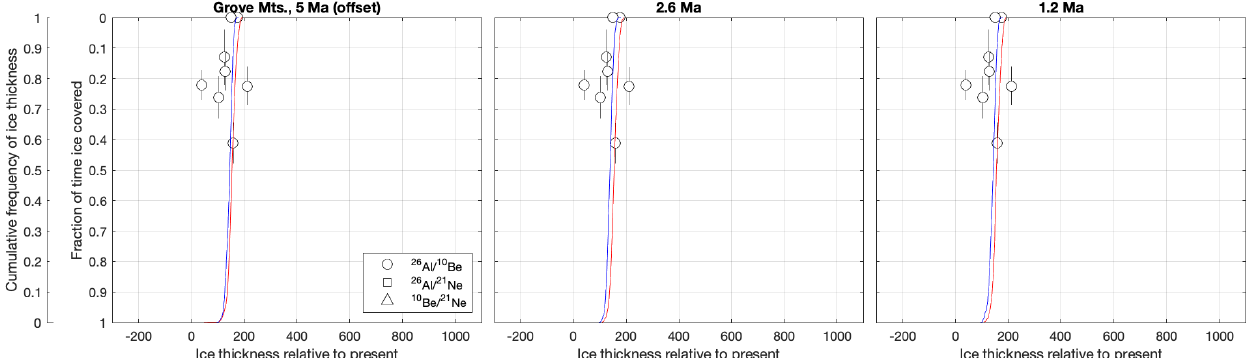
Figure 11. Ice cover frequency estimates for the Grove Mountains in East Antarctica inferred from paired 26 Al / 10 Be data and the inversion code of Spector et al. (2020), compared with sensitized and desensitized model CDFs for the same site. As in Fig. 10, model CDFs have been offset in elevation to align them with the centre of the group of data points. Data are described in Huang et al. (2008), Lilly (2008), Li et al. (2009), Kong et al. (2010), Liu et al. (2010), and Lilly et al. (2010). Sample elevations relative to the present ice margin are taken directly from the source publications without additional